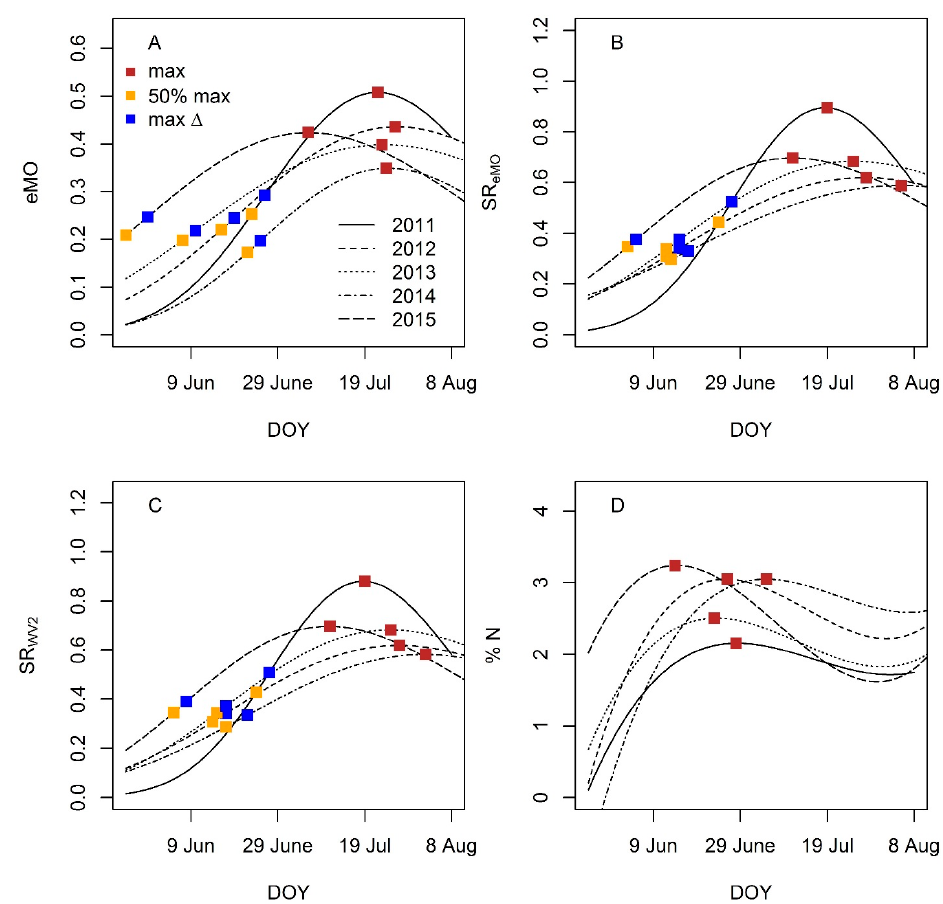
Figure 5. Seasonal trends in NDVI and percent nitrogen of halophytic graminoids at the Colville River Delta, Alaska, 2011–2015. Plots represent: ( A ) NDVI values derived from eMODIS satellite imagery (eMO); ( B ) NDVI values derived from handheld spectrometer using eMODIS band definitions (SR eMO ; ( C ) NDVI values derived from handheld spectrometer using Worldview-2 band definitions (SR WV2 ); and ( D ) percent nitrogen in above-ground vegetation (%N). Metrics of NDVI phenology included date of maximum (max), half maximum (50% max), and maximum rate of change (max Δ ). Annual seasonal trends for NDVI ( A – C ) were based on model-averaged predictions from Gaussian and lognormal non-linear regression while those for percent nitrogen ( D ) were based on a third-order